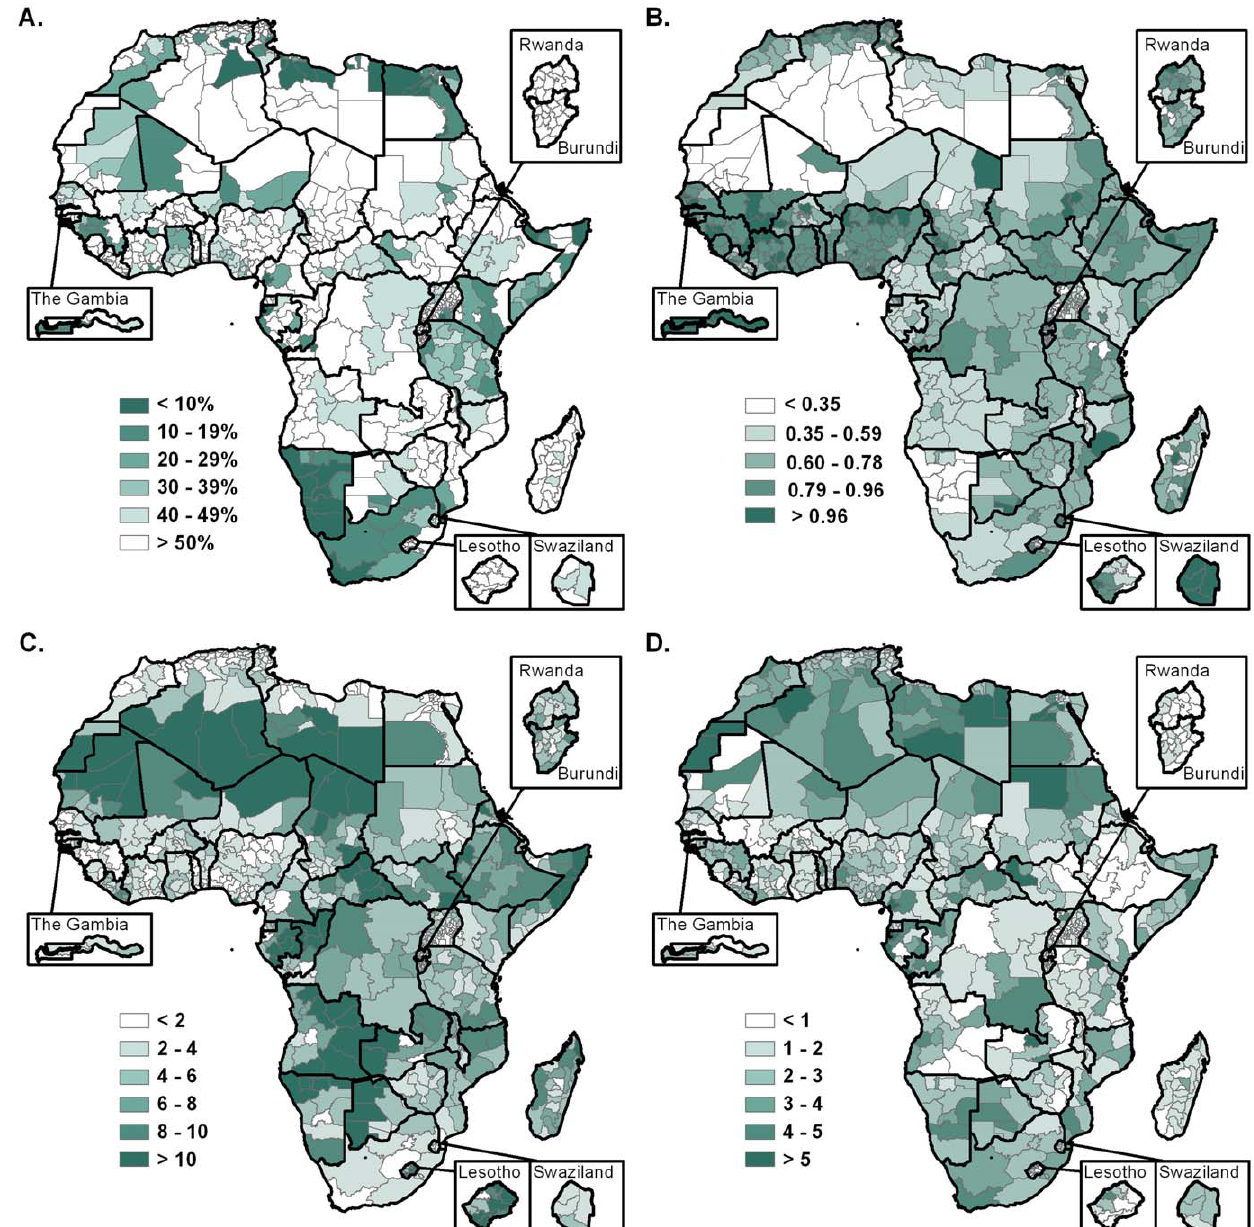
Figure 2. Measures for characterizing settlement patterns, population distribution and accessibility in Africa at administrative level 1. A. Percentage of land surface concentrating 90% of population. This measure emphasizes provinces of highly focal population distribution (in dark) and those where the population is more dispersed (in white). B. Clark and Evans aggregation index of settlement point patterns ( , 1 suggests clustering; . 1 suggests ordering). C. Average per-person travel time to nearest settlement with more than 50,000 people, calculated by combining the global map of accessibility [25] with our detailed population distribution dataset. D. Skewness of the average per-person travel time across the population. A high skewness (in dark) suggests that people are concentrated in cities, whereas a low skewness (in white) suggests that a high proportion of population resides in relatively inaccessible areas.